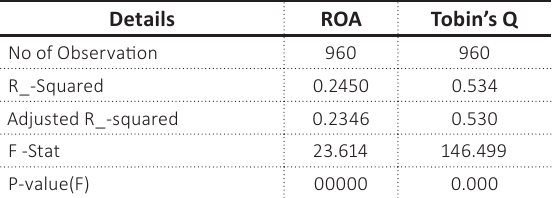
Table 3. Panel regression result: board characteristics, risk management practices, and ROA